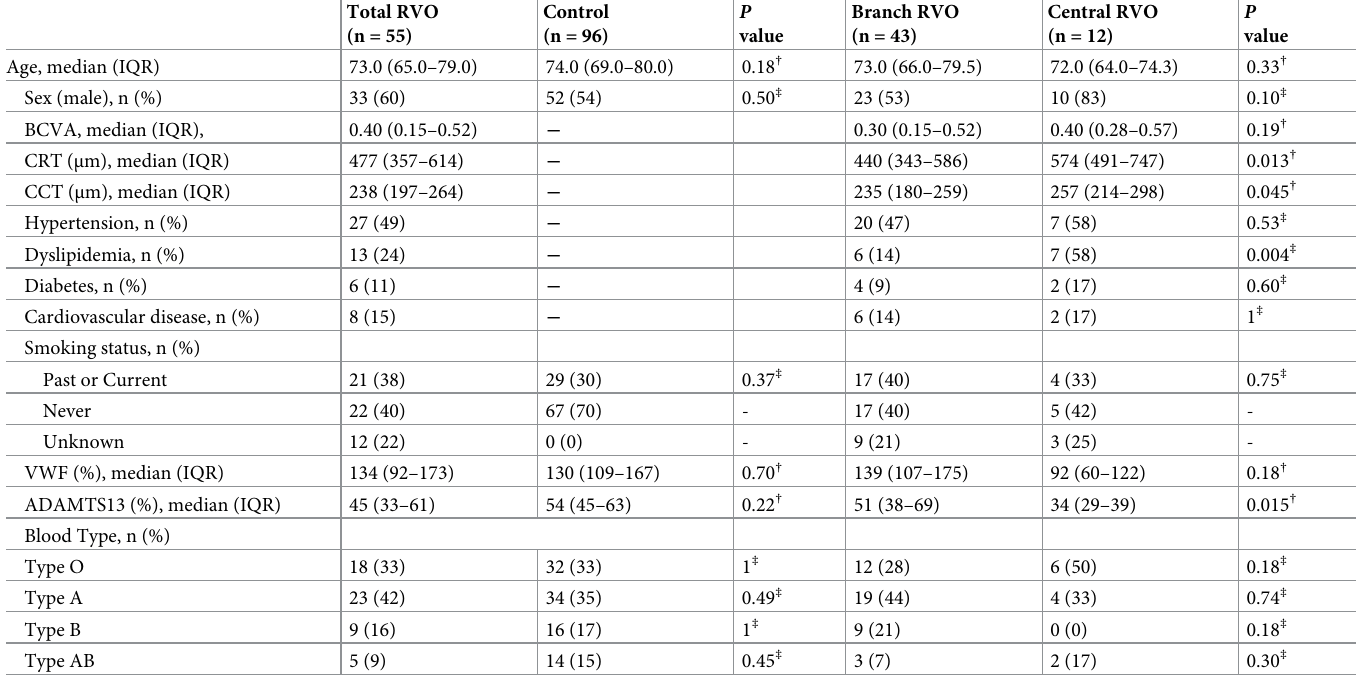
Table 1. Basic characteristics of RVO patients and